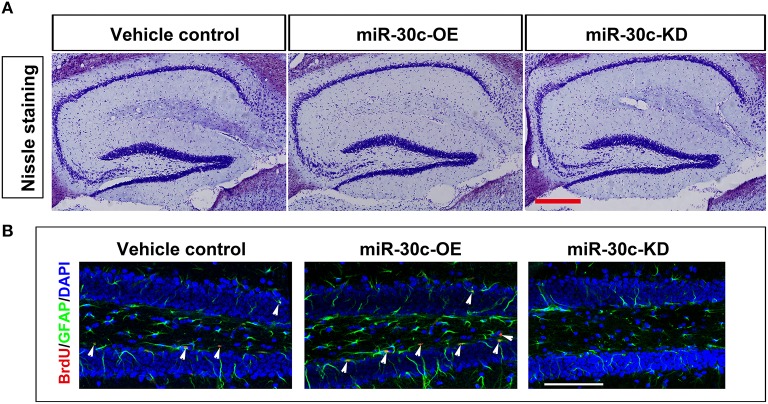
Nissle staining and newborn cells' assessment in DG. (A) DG whole morphology detection. Scale bar, 200 μm (B) Representative images of BrdU-labeled cell in DG by cumulative injection of BrdU for 7 days. Scale bar, 100 μm; n = 60 sections, four mice/group. Arrow heads, BrdU-labeled cells.